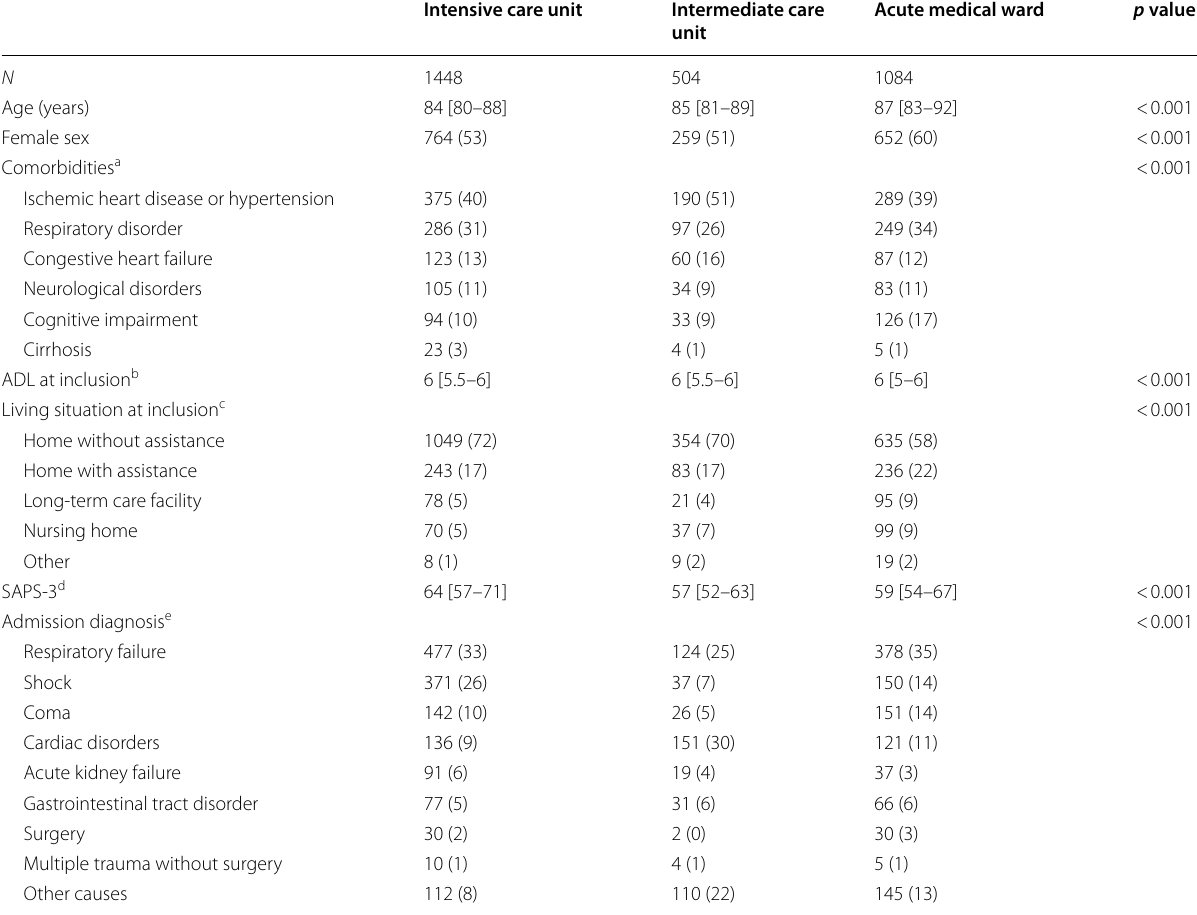
Table 1 Patient